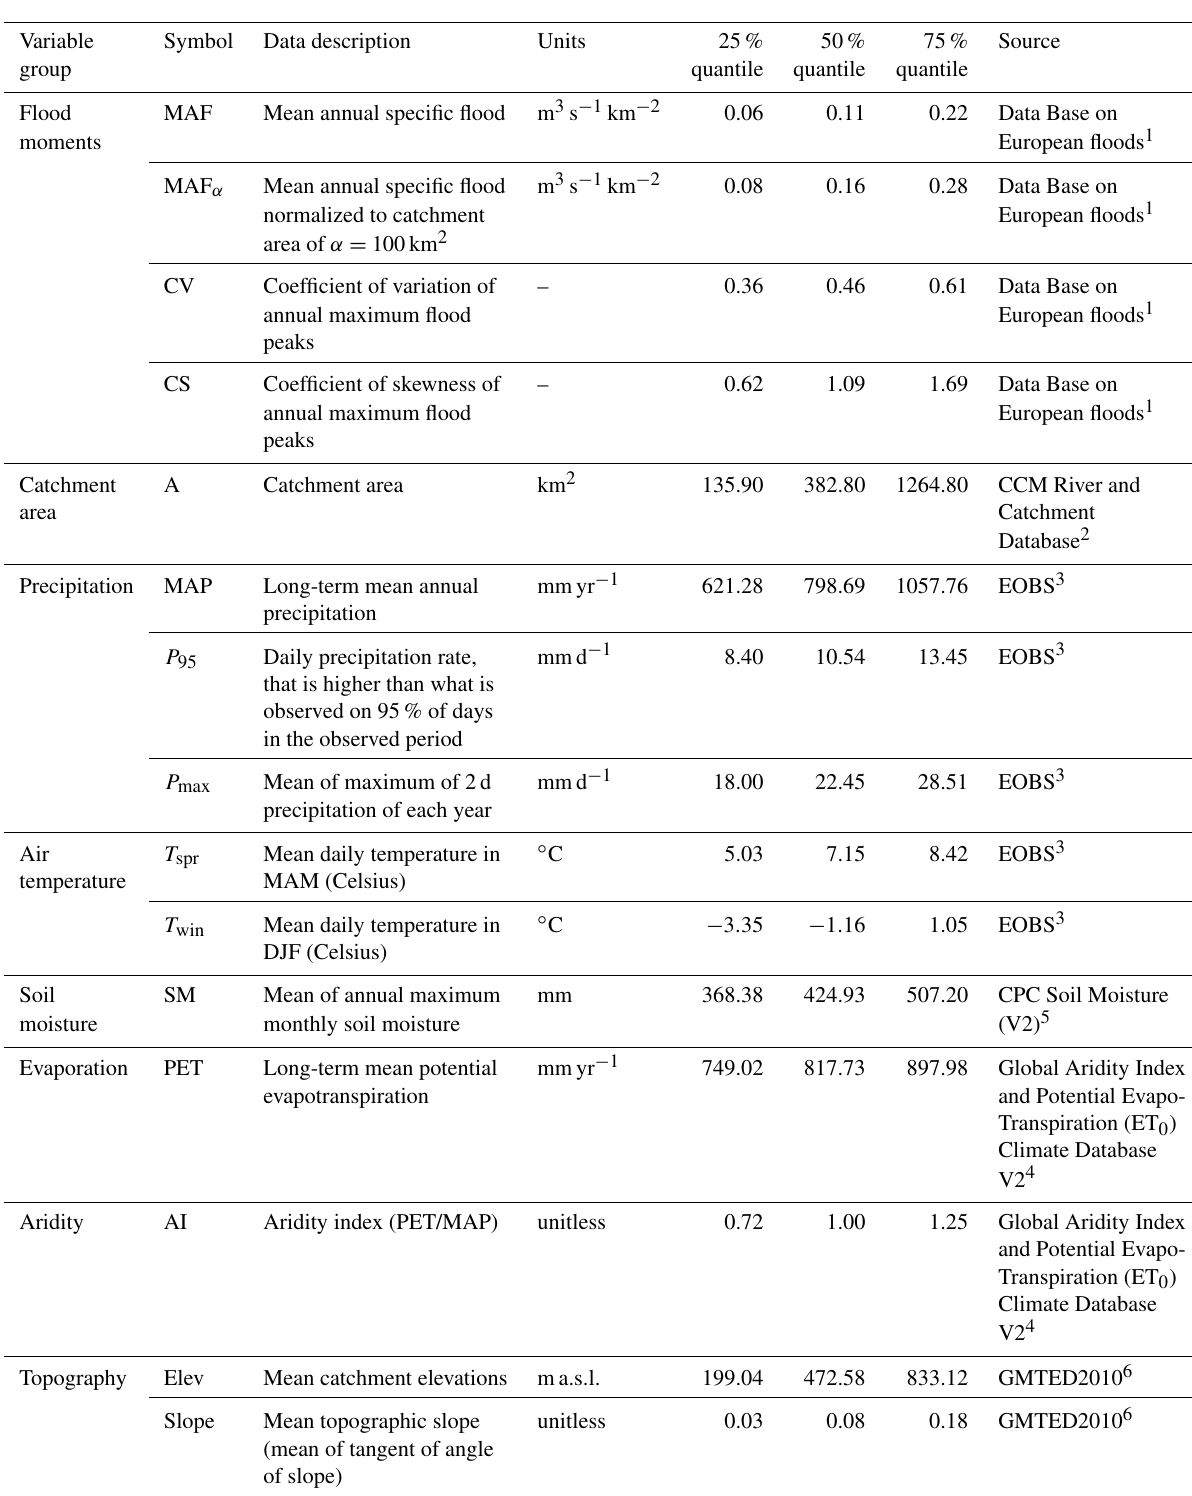
Table 1. Data used in this study, including quantiles of the variables and source information.